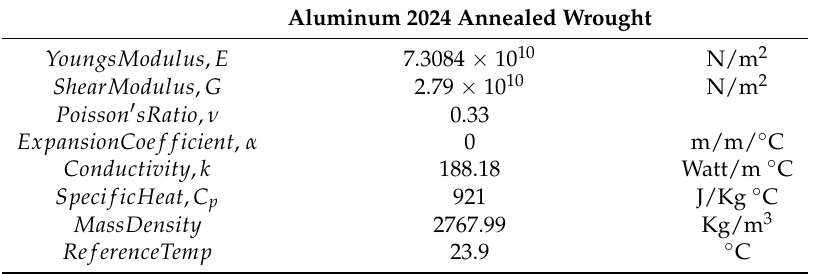
Table 3. Material